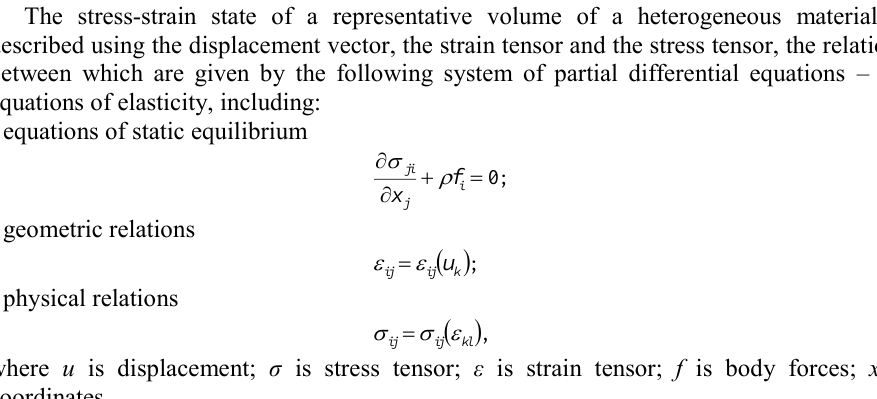
Fig. 3. Elastic medium